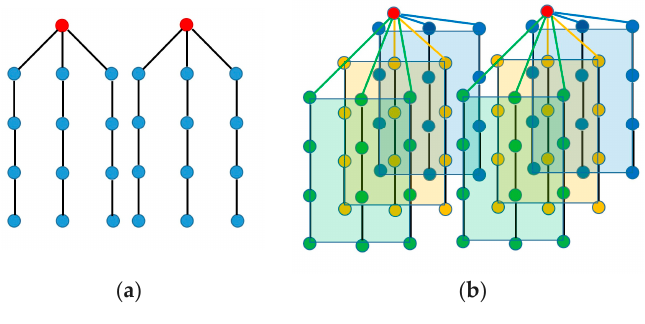
Figure 8. ( a ) 2D Grid; ( b ) 3D Grid.